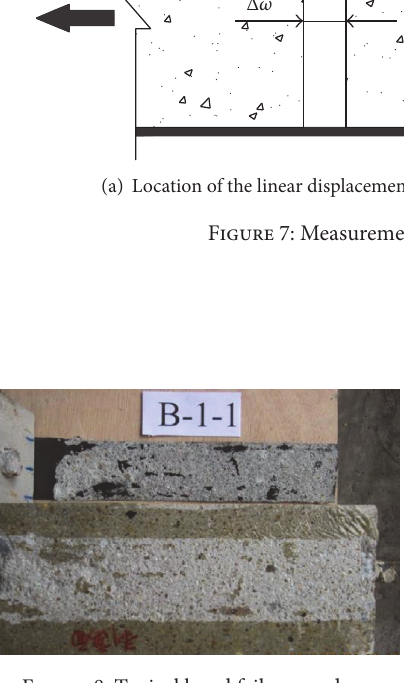
Figure 8: Typical bond failure